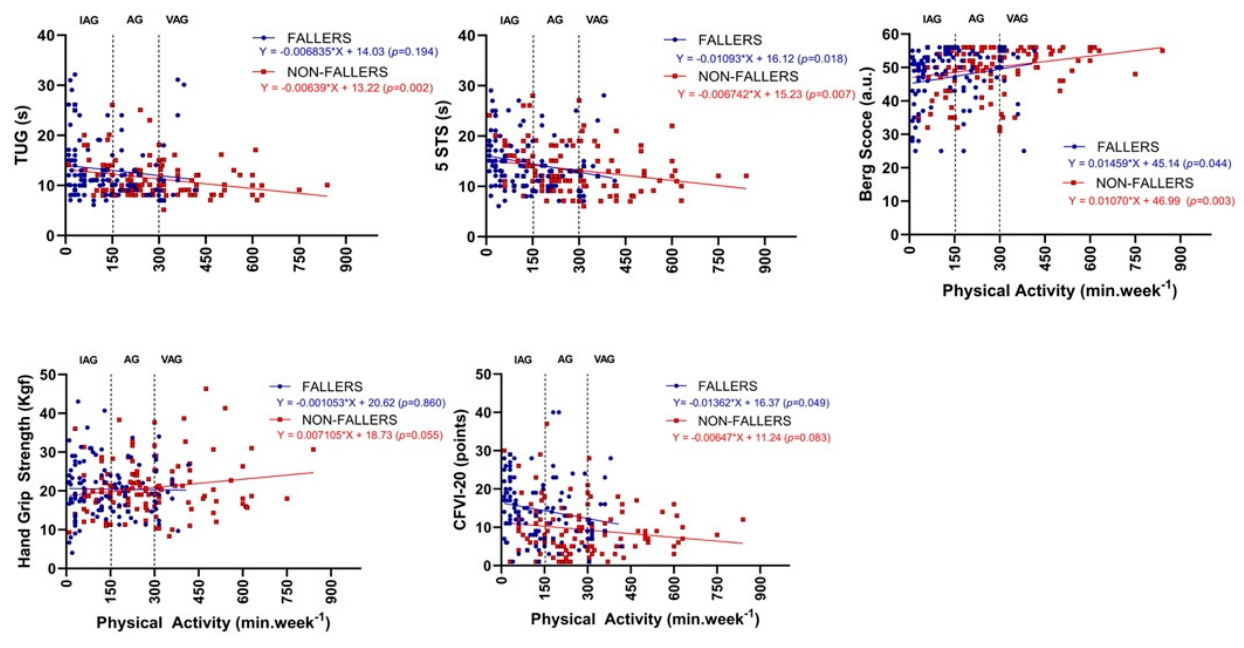
Figure 2. The relationship between physical activity and the functional capacity tests and frailty (CFVI-20) of oldest-old adults with (blue circles) and without (red squares) fall history. Note: The vertical dashed lines indicate the limits for the insufficient (IAG), active (AG), and very active groups (VAG). The blue and red solid lines represent the fitted lines of the linear regression equations. The linear regression equations and significance levels are presented in the legends.